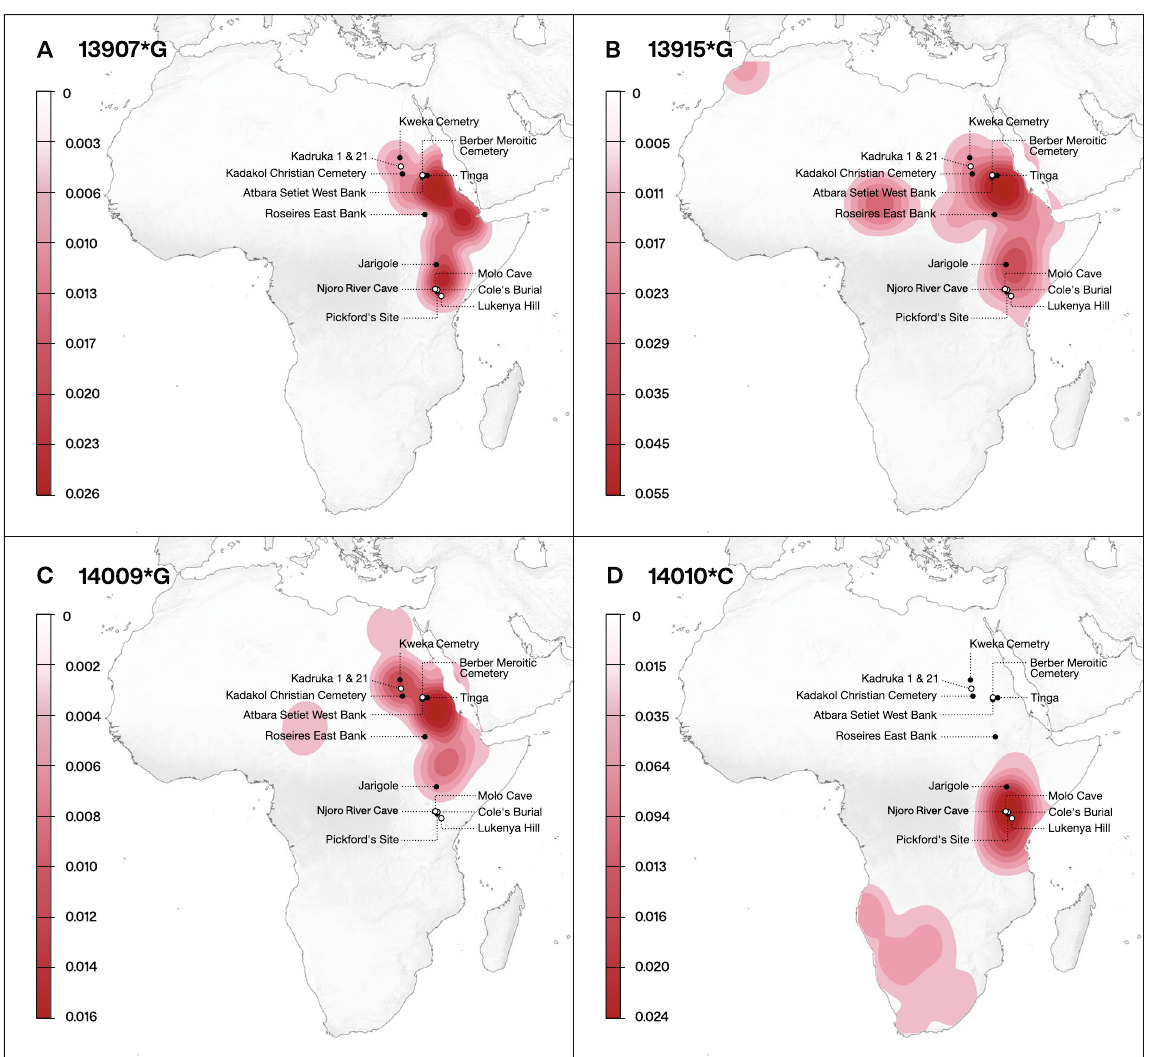
Fig. 1 Locations of sampled archaeological sites in Kenya and Sudan in relation to the distribution of main lactase persistence alleles found in modern populations in Africa. A 13907*G, B 13915*G, C 14009*G, and D 14010*C. Filled circles represent sites where milk proteins were identi fi ed in dental calculus samples, and empty circles are sites where samples did not yield milk proteins. The map was created for this study by Michelle O ’ Reilly (Graphic Designer for the Max Planck Institute for the Science of Human History, Jena, Germany) using QGIS 3.12 [https://qgis.org/en/site/] and the Natural Earth Database from [https://www.naturalearthdata.com/downloads/] and Adobe Illustrator CC. Heat maps were generated using published LP distribution frequencies 6